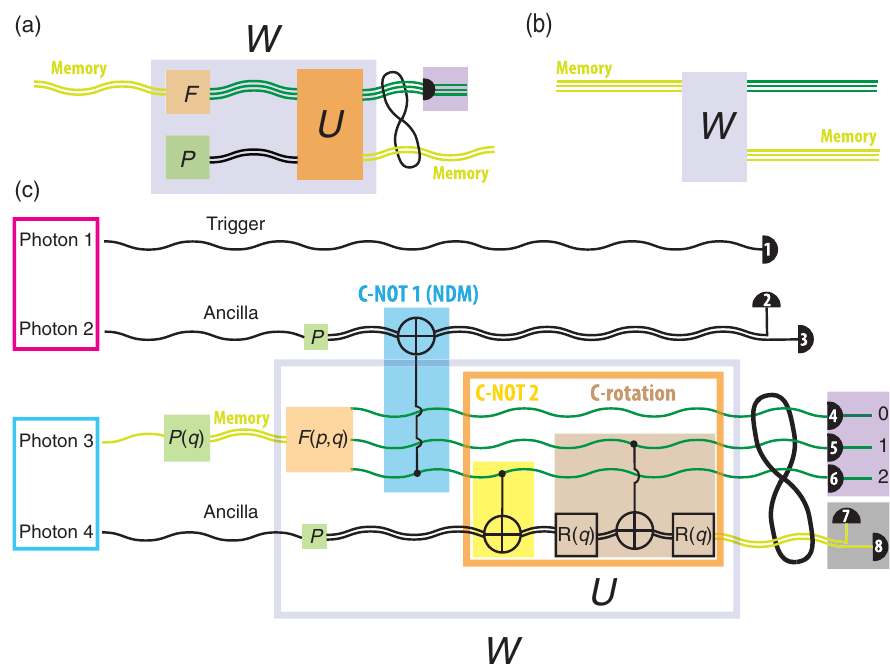
FIG. 2. Conceptual diagram of a simulation step. (a) The quantum processor ( W ) accepts a memory qubit and uses an ancilla. (We use wavy lines to denote quantum objects, with the number of lines in parallel indicating the dimensionality.) In the processor, the qubit undergoes a fan-out operation F to a qutrit space. The ancilla contains no information, and its preparation P is fixed. Then, a unitary operation U acts on the qutrit and ancilla, outputting an entangled state of the memory qubit and a qutrit. A projective measurement of the qutrit provides the output of the simulation step and collapses the memory qubit to the appropriate state for the next step. (b) The classical simulator requires a three-dimensional memory system. The irreversible operation W acts on the memory system to generate the classical output and the next memory state. (c) The experimental realization of the circuit in diagram (a) using linear optics gates requires an ancilla qubit (Photon 2) and its herald (Photon 1). Following the fan-out operation F ð p; q Þ on the memory qubit, we implement a gate, C-NOT 1, which performs a nondestructive measurement (NDM). Then, the unitary operation U is performed by an additional two gates, C-NOT 2 and C-rotation. The preparation P ð q Þ of the memory system (Photon 3), the fan-out operation F ð p; q Þ , and the single qubit rotation R ð q Þ depend on the stochastic process parameters p and q as